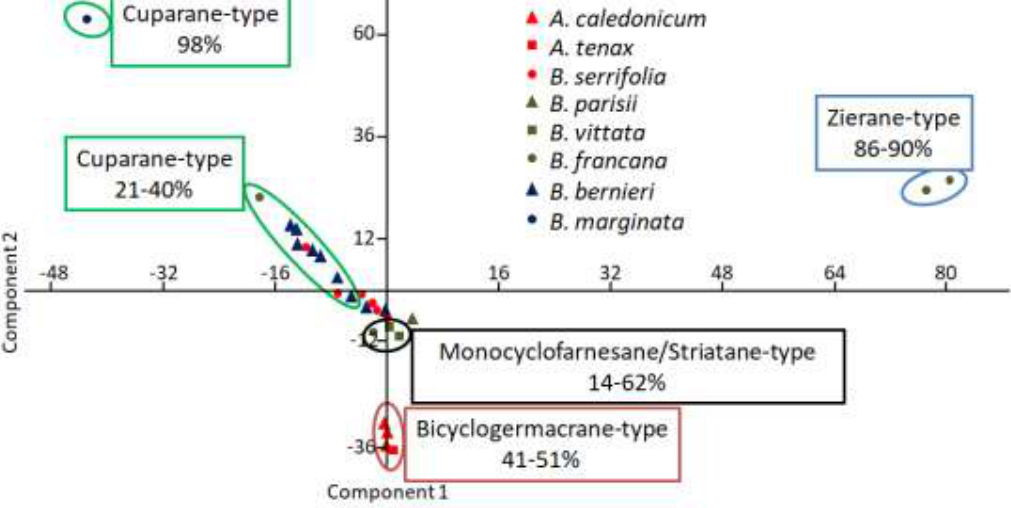
Figure 8. Principal Components Analysis (PCA) plot of sesquiterpene-type distribution of studied New-Caledonian Bazzanioideae order (PC1 = 36.7%; PC2 = 27.8%). New-Caledonian Bazzanioideae order (PC1 = 36.7%; PC2 =